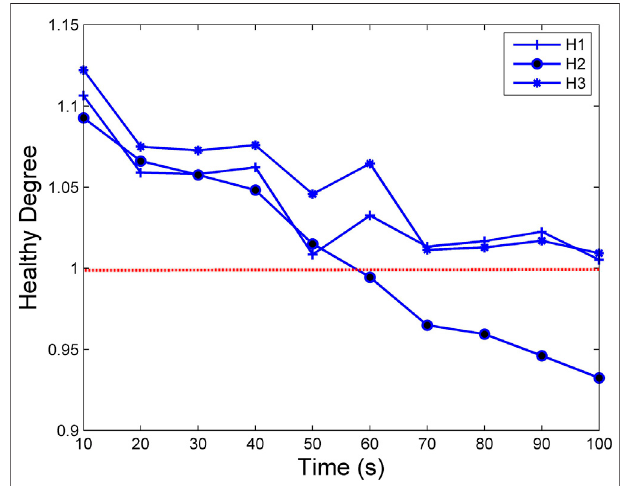
FIGURE 2 | Fault prediction curves of engine equipment from normal operation to fault 2. It is evident that only the fault prediction curve of fault 2 whose healthy degree starts to be less than 1 in the time period from 50 to 60 s.